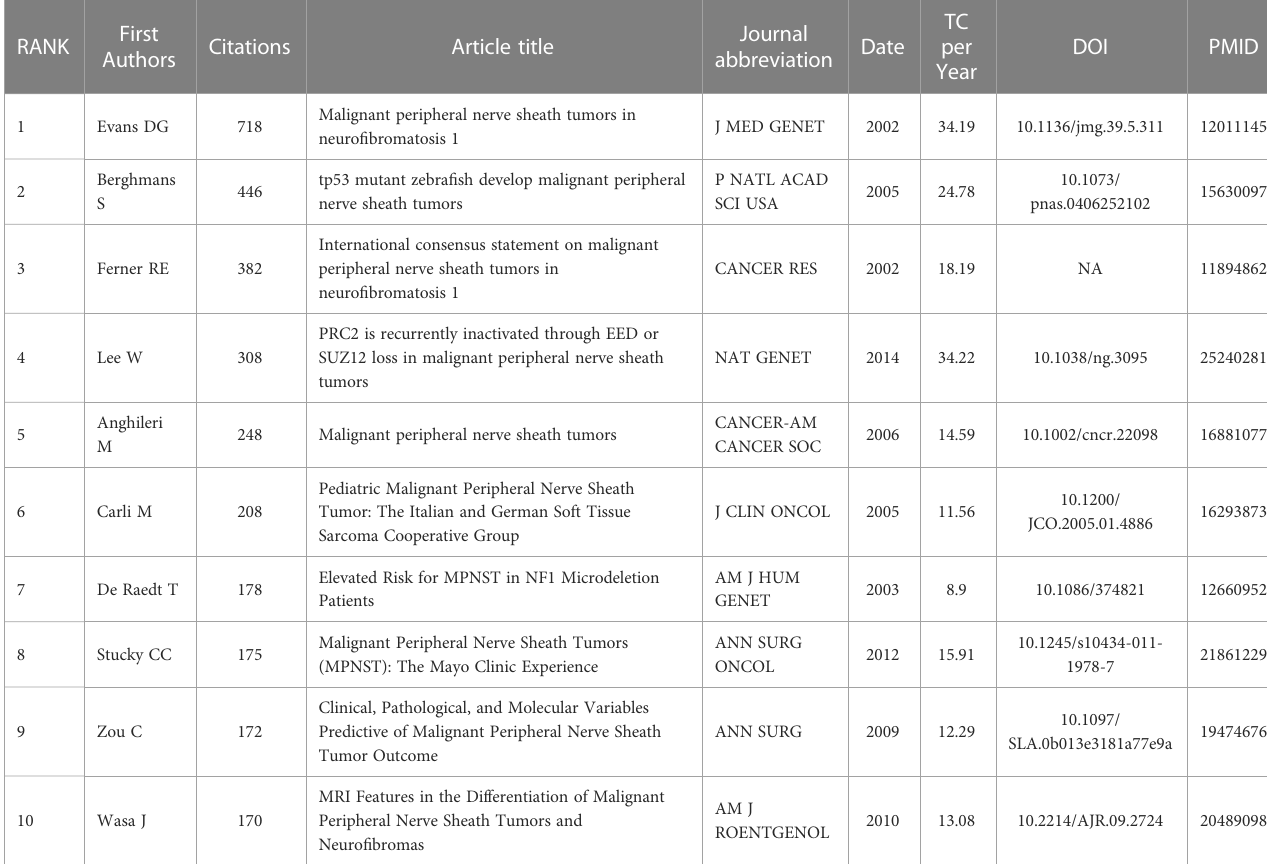
TABLE 7 The ten most cited publications in